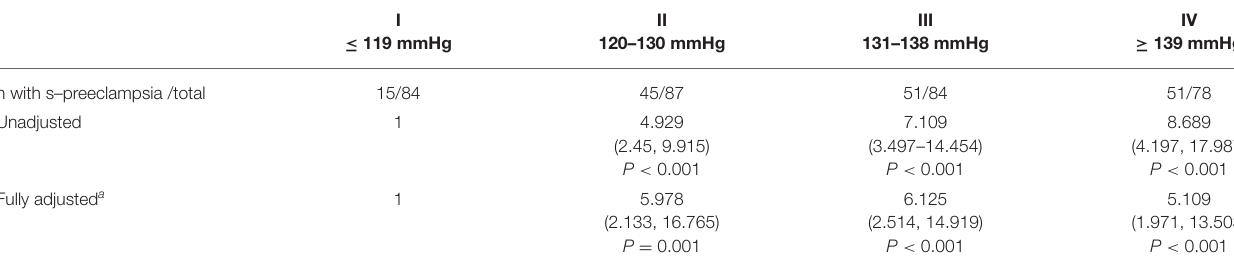
TABLE 5 | Association of prenatal first SBP and severe